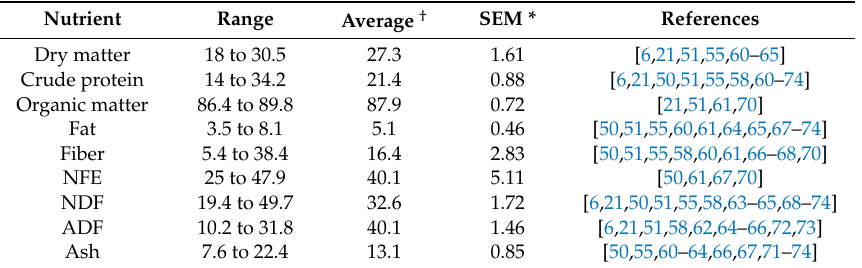
Table 1. Chemical composition of mulberry leaves (%).